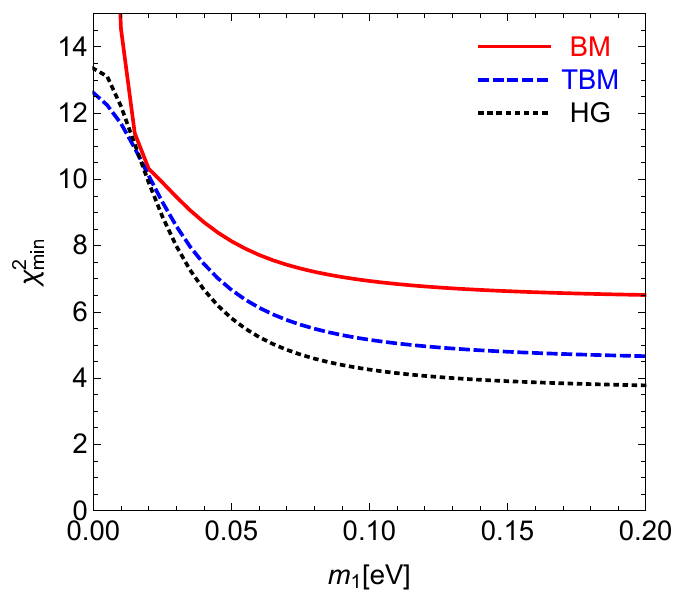
Figure 1 . The minimum value of (cid:31) 2 as a function of m 1 at DUNE. Here BM, TBM and HG correspond to (cid:18) 0 = 45 (cid:14) , 35 : 3 (cid:14) , and 30 (cid:14) , 12